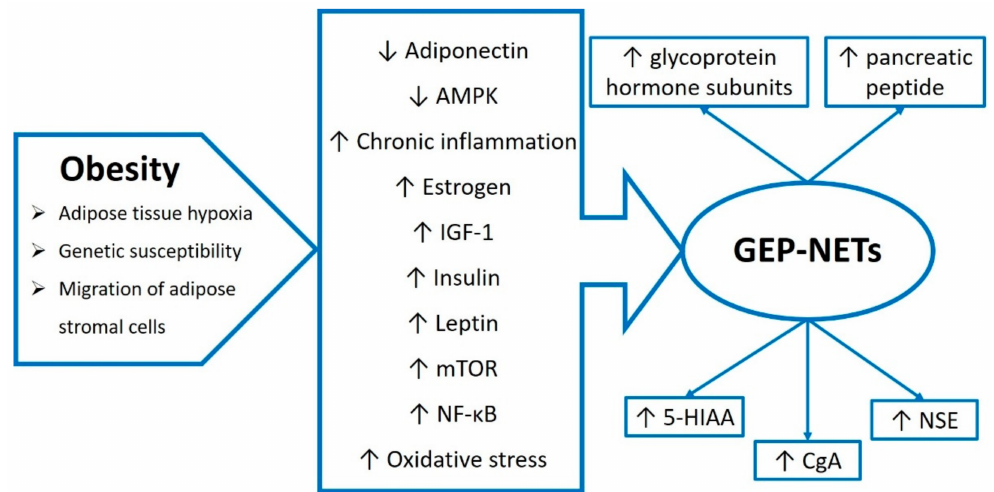
Figure 2. Relationship between obesity and gastroenteropancreatic neuroendocrine tumors (GEP- NETs). Abbreviations used: 5-HIAA: 5-hydroxyindole acetic acid; AMPK: AMP-activated protein kinase; CgA: chromogranin A; IGF-1: insulin-like growth factor-1; mTOR: mammalian target of rapamycin kinase; NF- κ B: nuclear factor kappa B; NSE: neuron-specific enolase. The upwards arrow indicates an increase in the parameter’s level; the downwards arrow indicates a decrease in the parameter’s